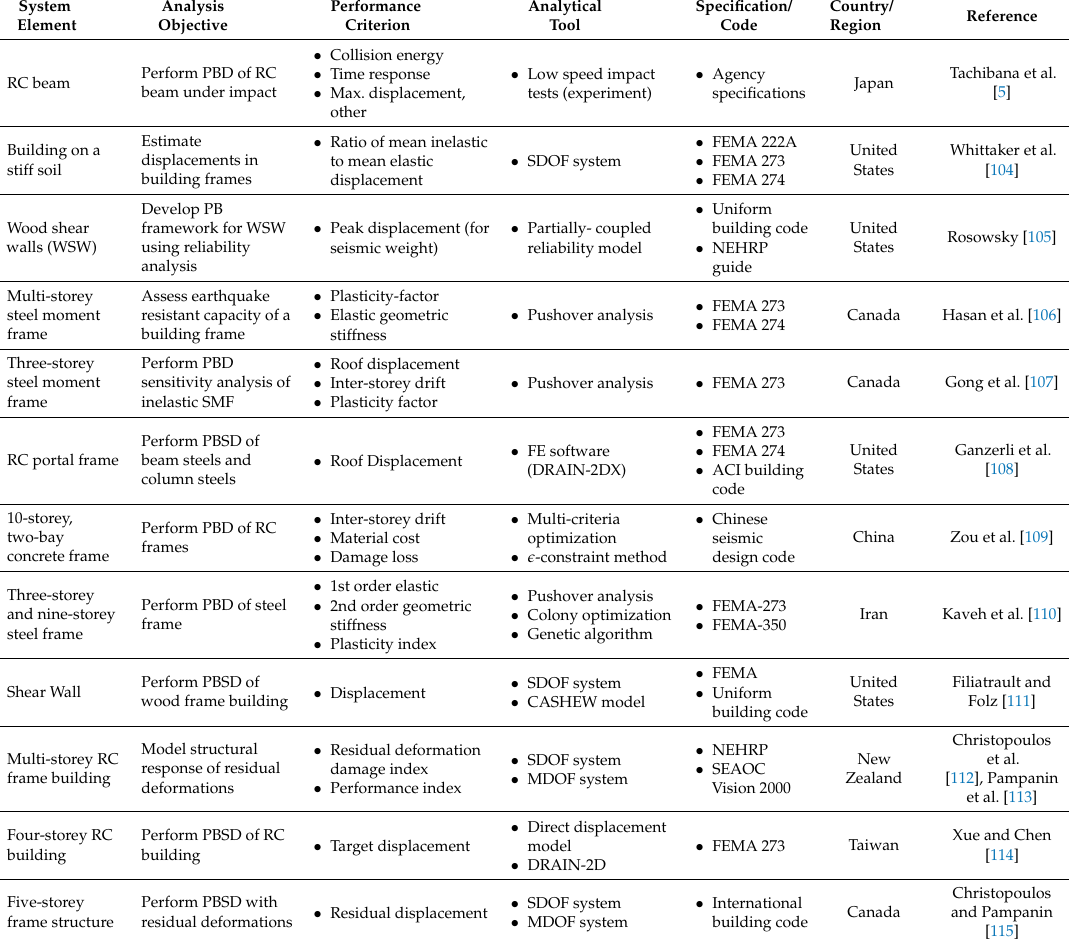
Table A8. Characteristics of building earthquake-based design applications (traditional